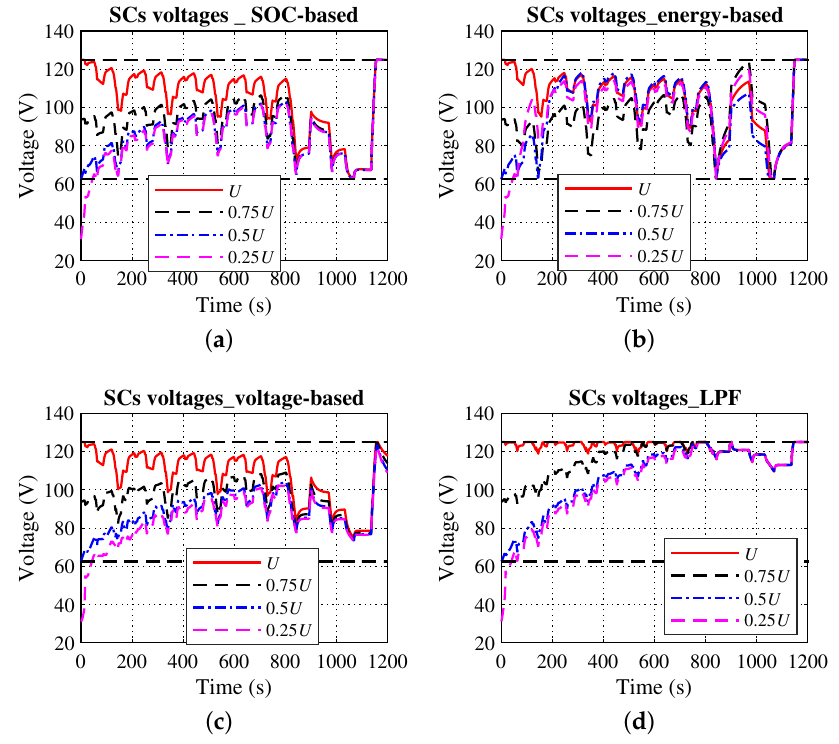
Figure 14. SC voltages with the studied strategies in the NEDC: ( a ) SOC-based strategy; ( b ) Energy- based strategy; ( c ) Voltage-based strategy; ( d ) Conventional filtering